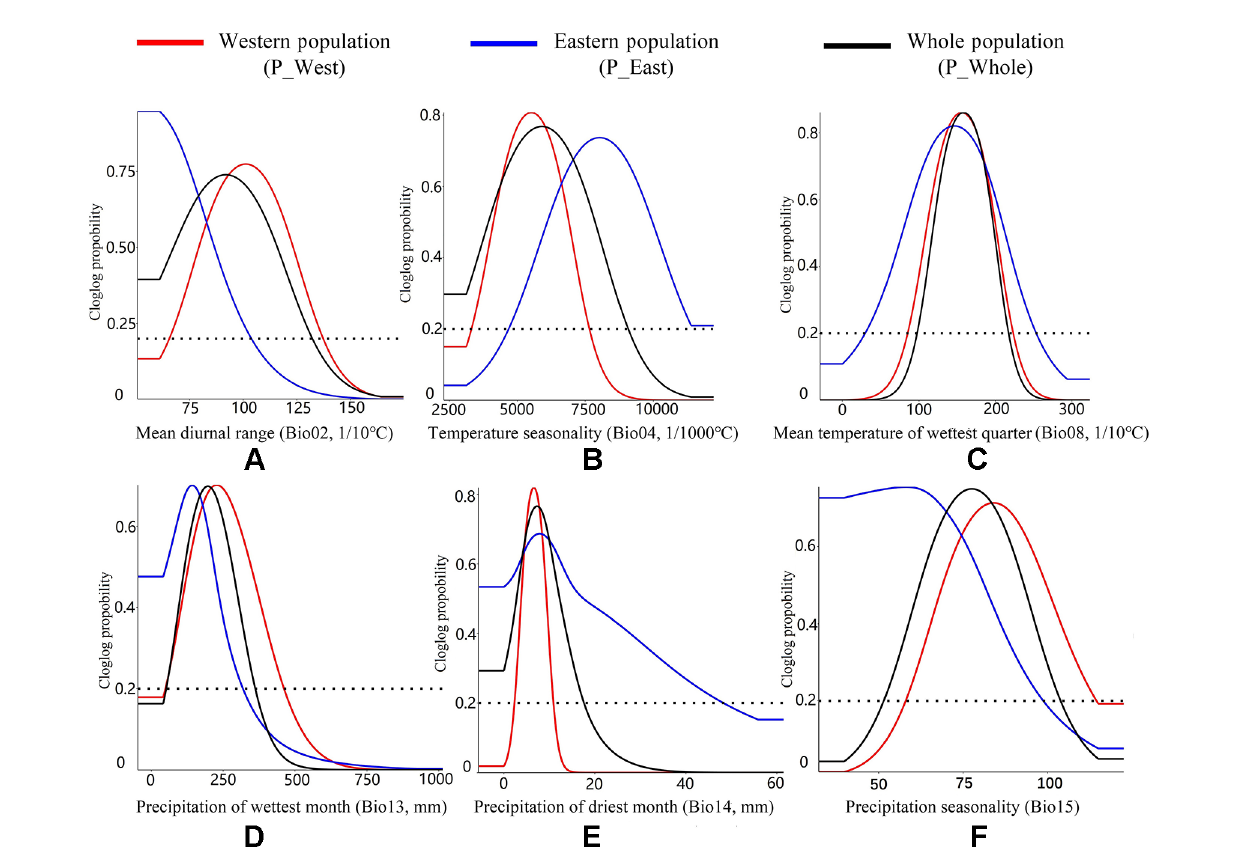
FIGURE 8 | Response curves of allclimate variables. The Y-axis shows the relative probability of the presence of P. mairei under a given value of each climate variable applied inour research. (A) Western population might adaptto a higher mean diurnaltemperature range; (B) Eastern population might adaptto a higher temperature seasonality; (C) Two populationsperforms an stability inMean temperature of wettest quarter; (D) Westernpopulation might adaptto a higher precipitation of wettestmonth; (E) Easternpopulation might adaptto a higher precipitation of driest ofmonth; (F) Western population might adapta higher precipitation